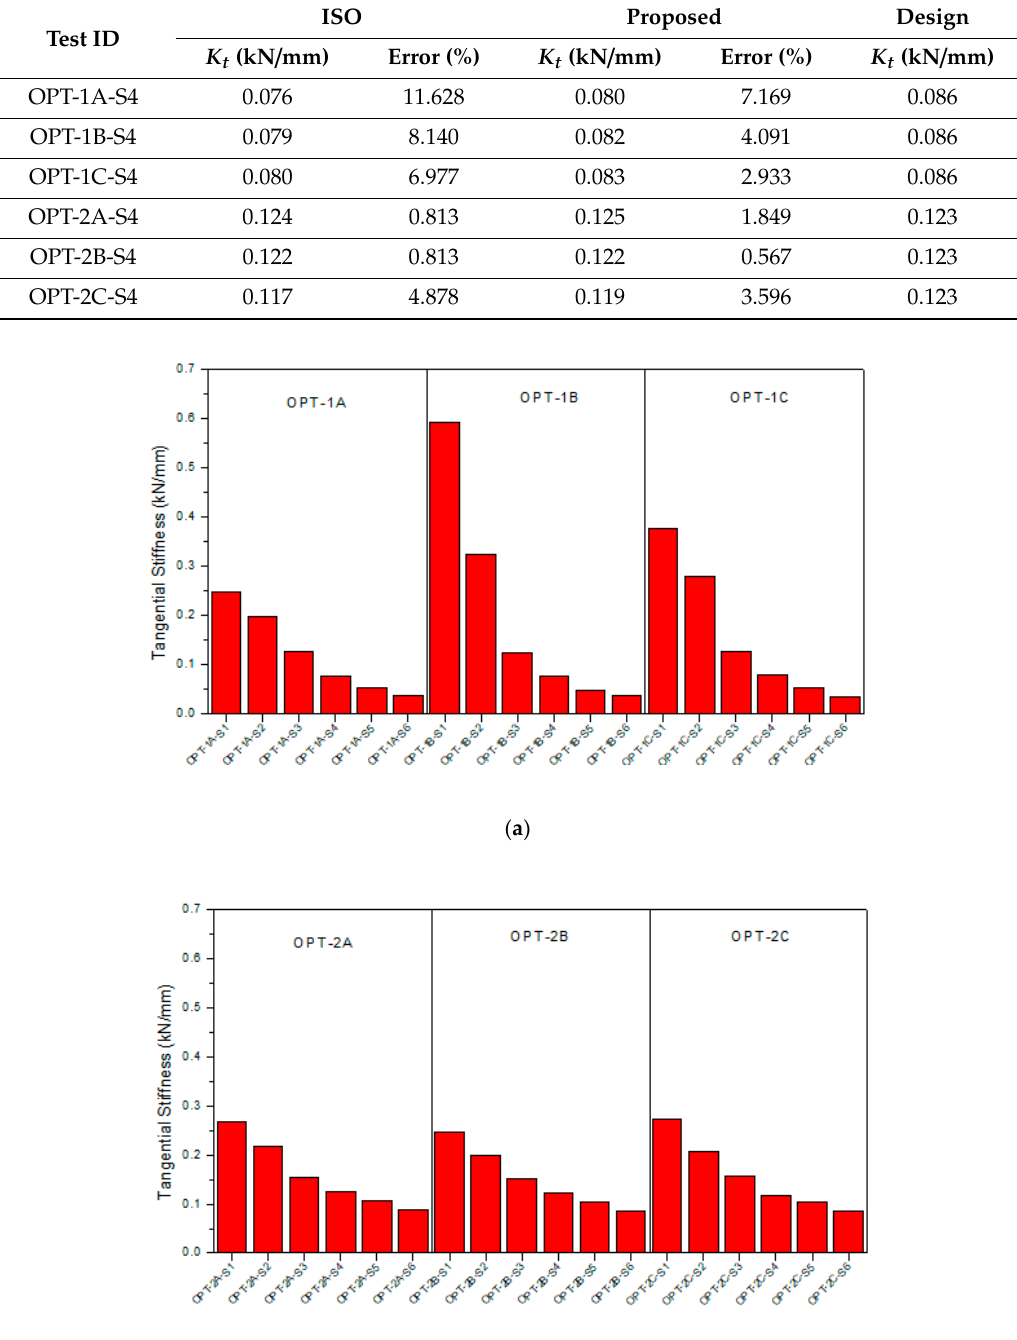
Table 6. Results of tangential sti ff ness (D = ± 35 mm).